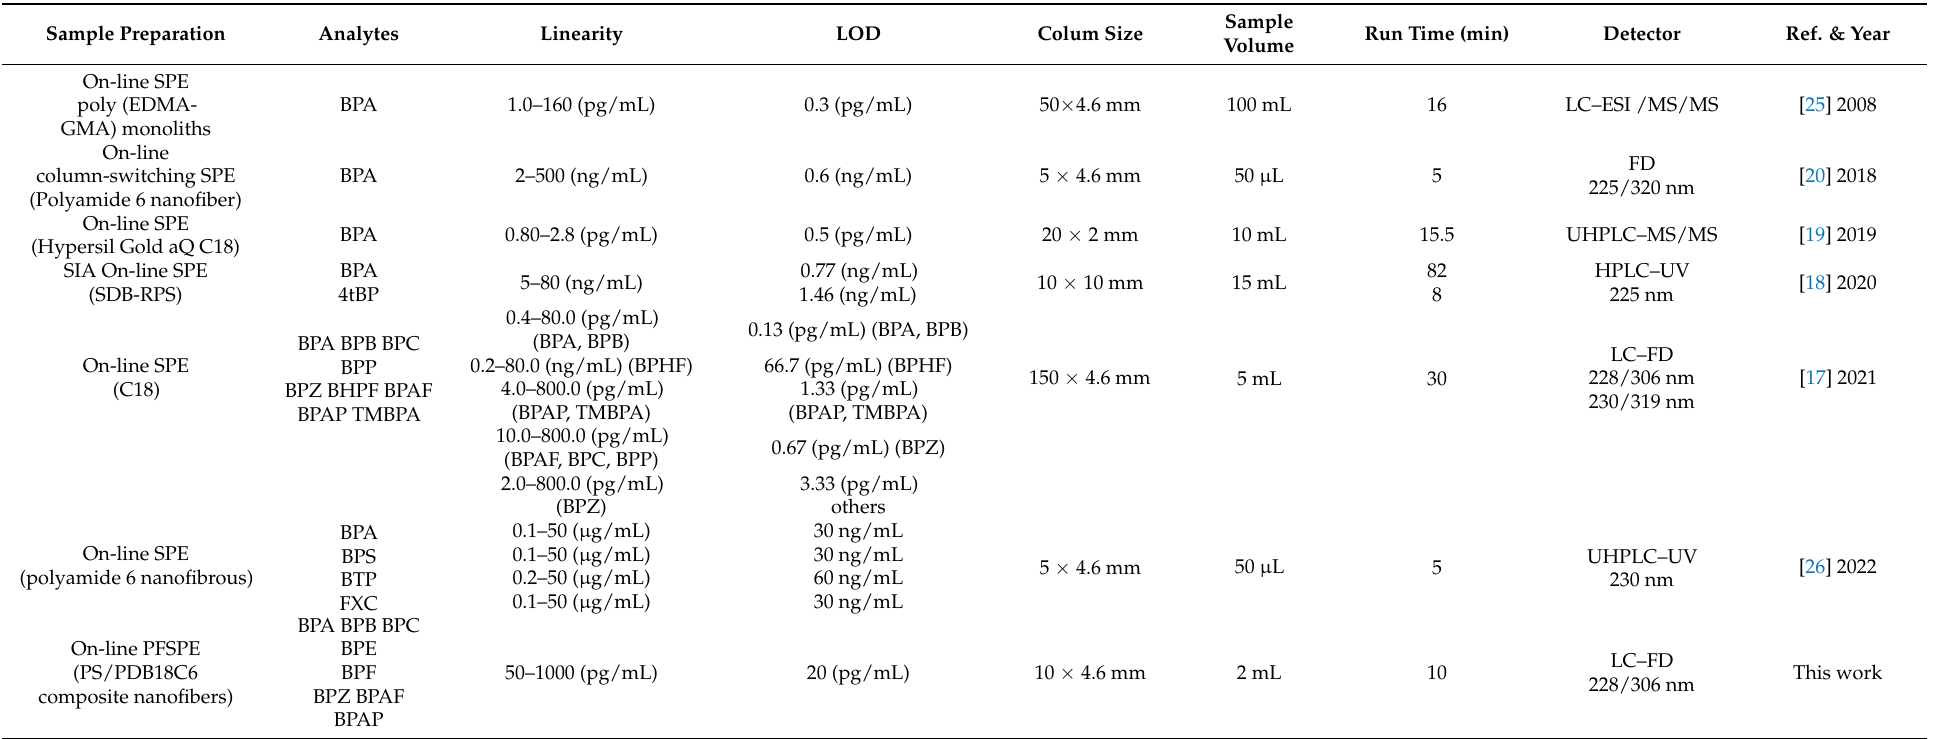
Table 4. Comparison of analytical perform nce of the proposed method with existing on-line methods for detection of BPs in water